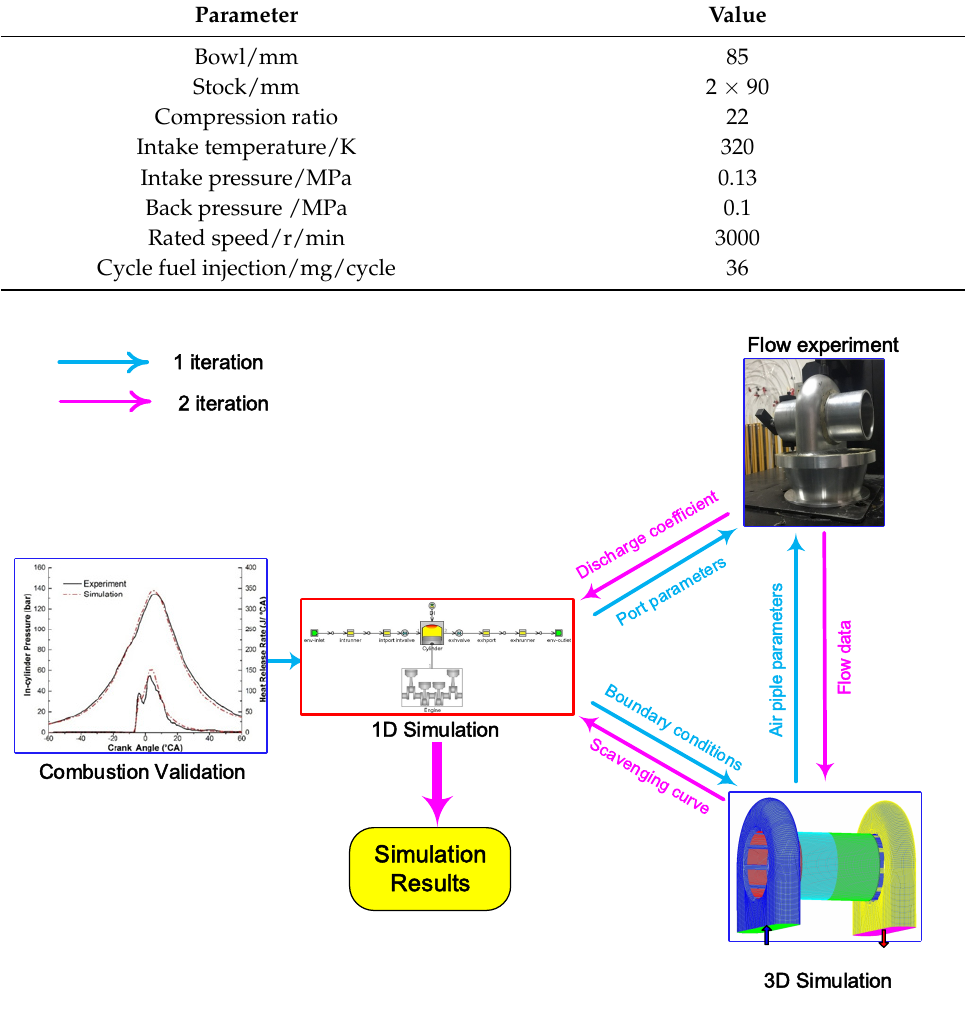
Figure 1. Validation of a 1D simulation